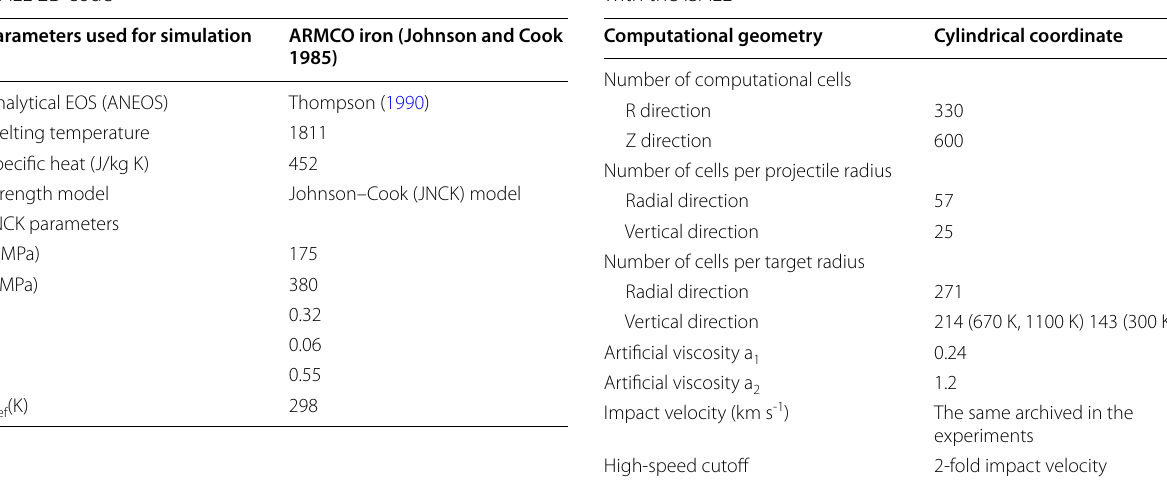
Table 3 Models and parameters used for simulation with the